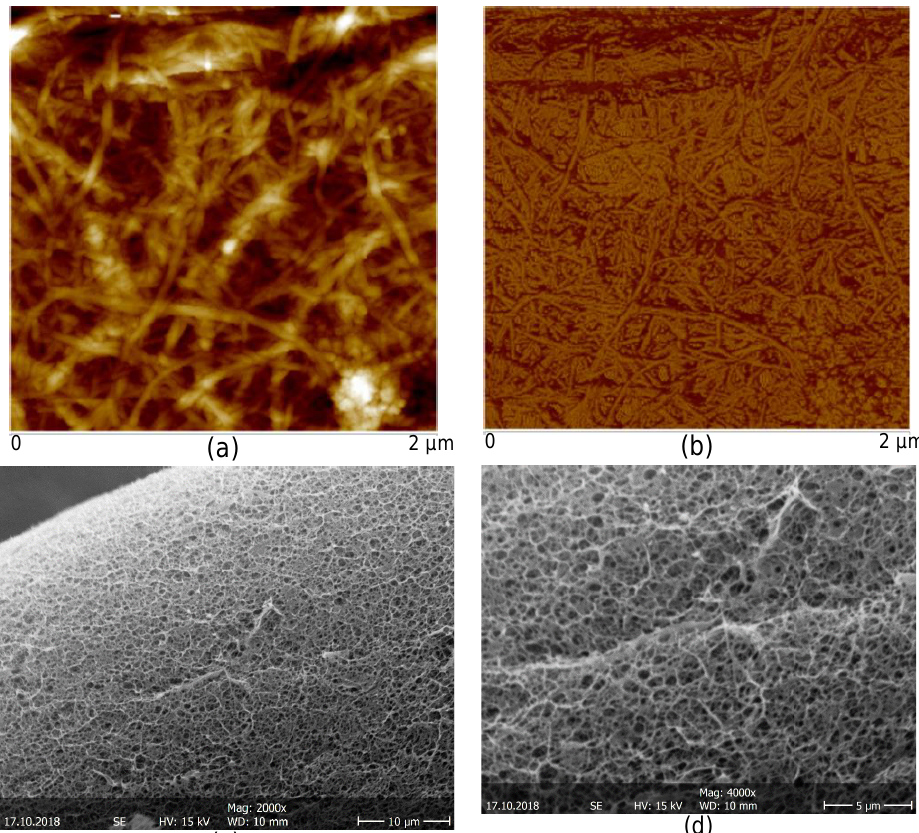
Figure 5. Atomic force microscopy AFM topography ( a ) and phase ( b ) images of the cellulose nanofibers CNFs used to reinforced the cellulose nanofiber-filled chitosan CNF/CHI hydrogel composites. SEM micrographs ( c , d ) of scaffolds obtained after freeze-drying of the CNF/CHI hydrogels (CHI 2%/CNF 0.3%).